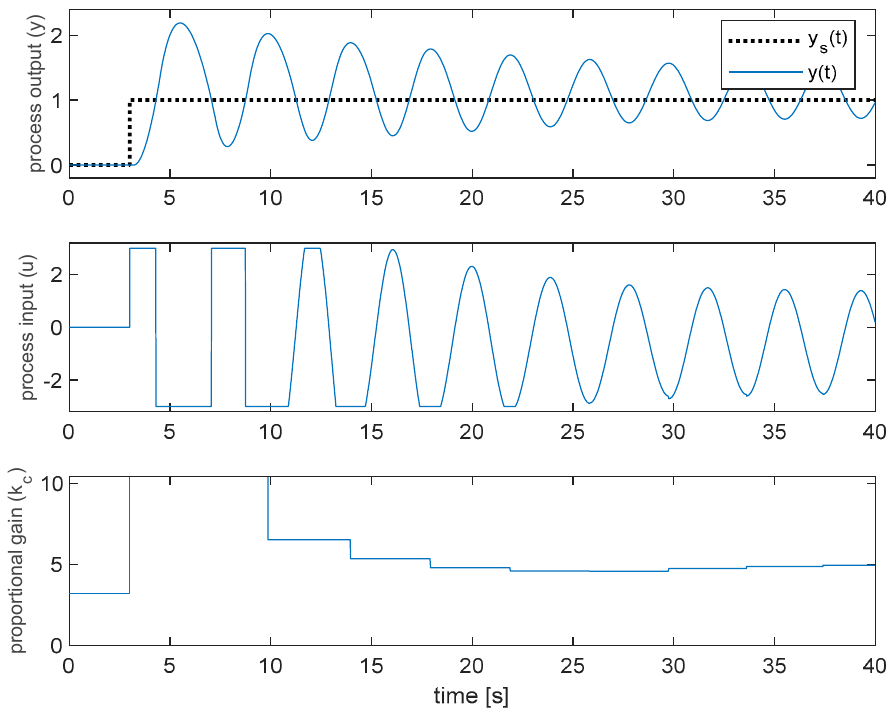
Figure 18. Response of the relay feedback method [1] for the integrating process and PA set = − π .